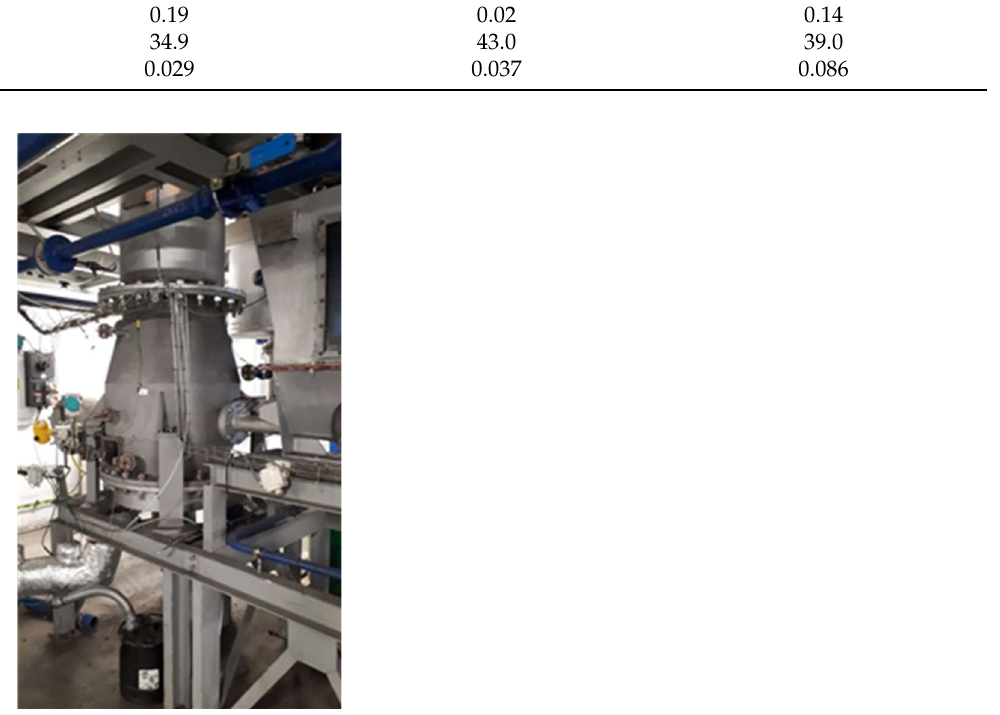
Figure 1. A photograph of part of the installation for solid fuels pyrolysis, located in the IChPW. In the testing installation, due to the high flue gas velocities (5–10 m/s), part of the fluidized bed material (residual biomass) is lifted from the reactor by a riser pipe and, after being separated in a cyclone (which is an integral part of the system), it is returned to the bottom part of the reactor. Such implementation of the process allows for a significant increase in efficiency, an improvement of a fuel conversion rate, and a reduction of tar content in the generated gas.